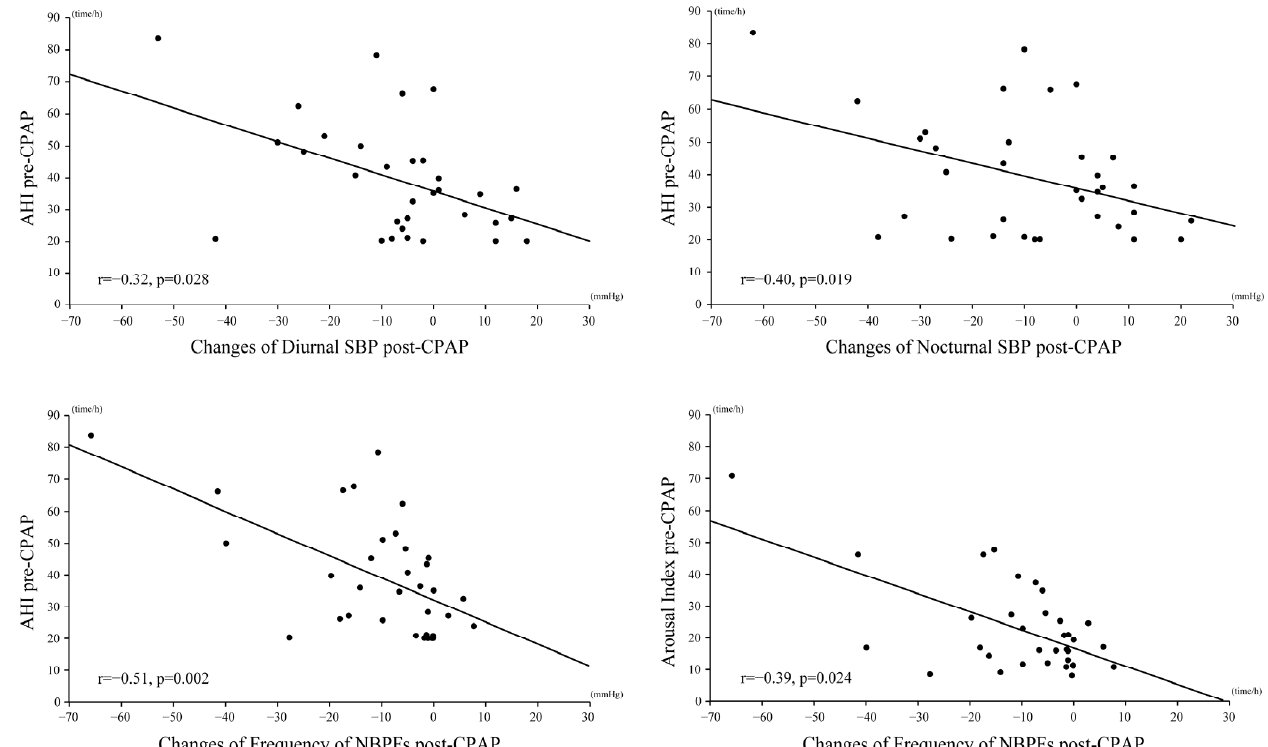
Figure 4. Correlation between sleep-related and nocturnal blood-pressure-related parameters. AHI, apnea-hypopnea index; CPAP, continuous positive airway pressure; DBP, diastolic blood pressure; NBPFs, nocturnal blood pressure fluctuations; SBP, systolic blood pressure.